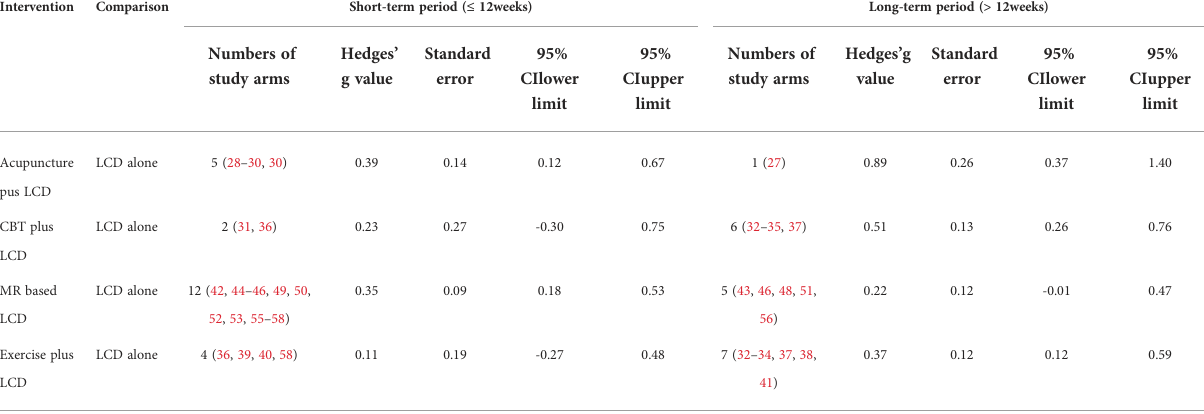
TABLE 4 Network meta-analysis of the effect size on weight loss by intervention period. Intervention